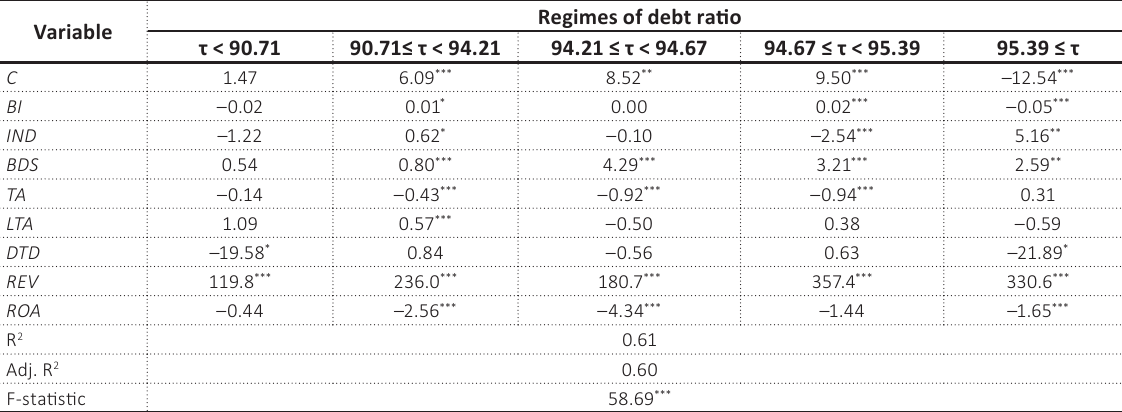
Table 6. Nonlinear effects on non-performing loans (NPL)